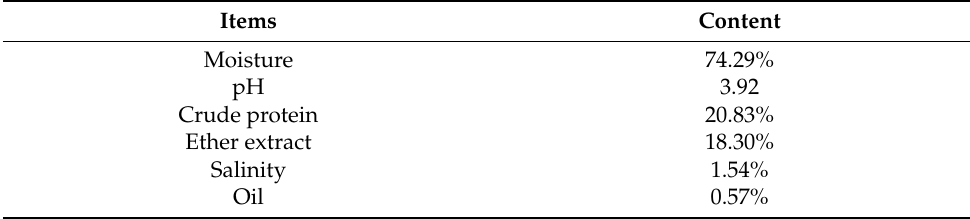
Table 1. Basic physical and chemical properties of KWTR.